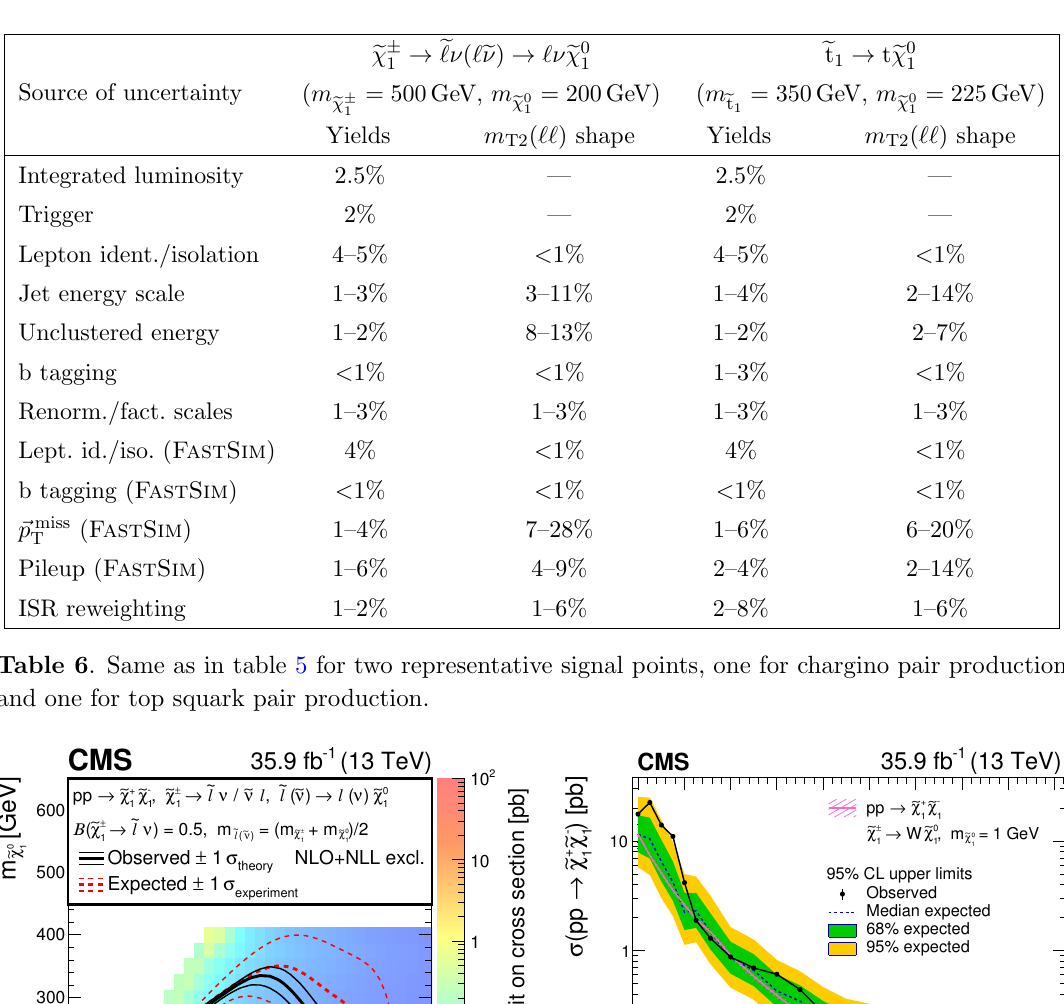
Figure 8 . Left: upper limits at 95% CL on chargino pair production cross section as a function of the chargino and neutralino masses, when the chargino undergoes a cascade decay ‘(cid:23) (cid:31) 0 . Exclusion regions in the plane ( m 1 with the NLO+NLL production cross sections. The thick dashed red line shows the expected exclusion region. The thin dashed red lines show the variation of the exclusion regions due to the e experimental uncertainties. The thick black line shows the observed exclusion region, while the thin black lines show the variation of the exclusion regions due to the theoretical uncertainties in the production cross section. Right: observed and expected upper limits at 95% CL as a function of the chargino mass for a neutralino mass of 1 GeV, assuming chargino decays into a neutralino